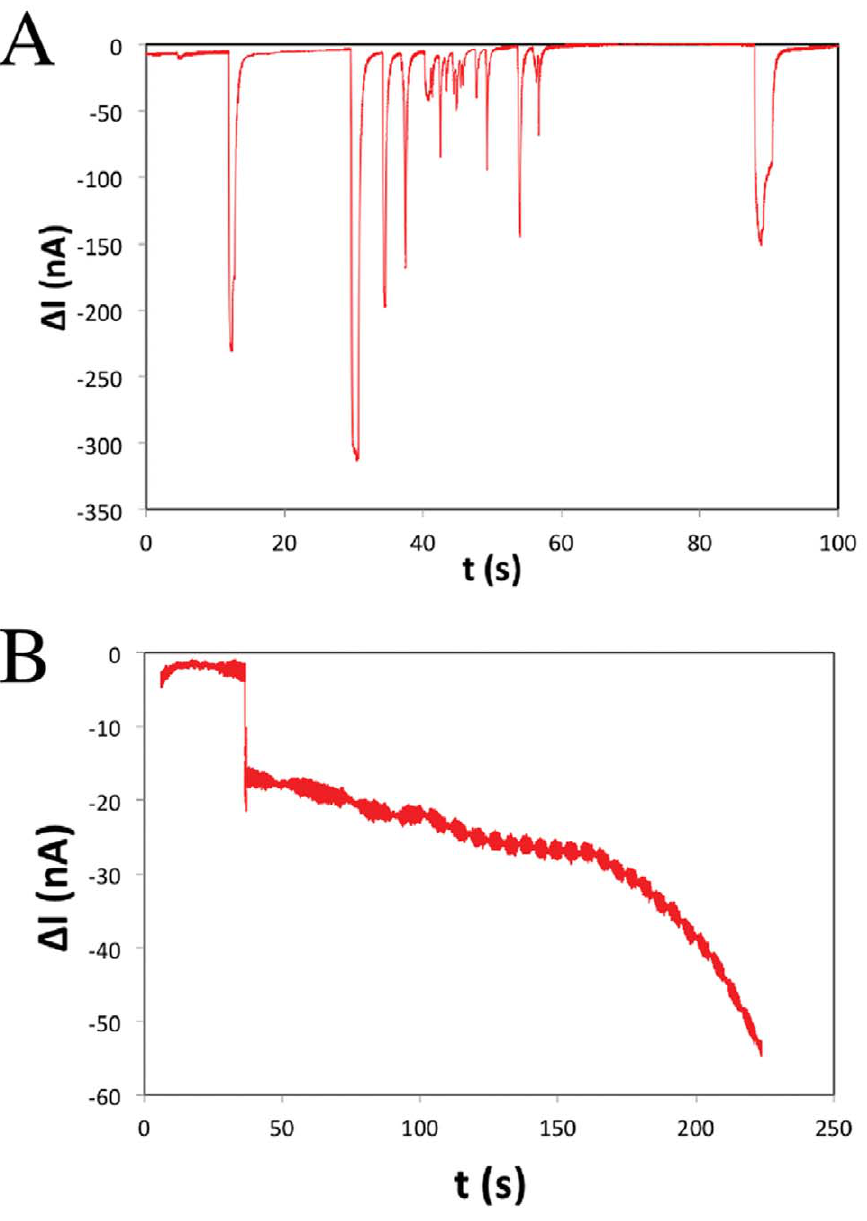
Figure 3. Typical current versus time traces of ODN-coated PS microparticles passing throughout an ODN-functionalized micropore. A. Translocation of PS-ncODN. B. Capture of PS-cODN. The bias potential across the micropore was 10 mV.